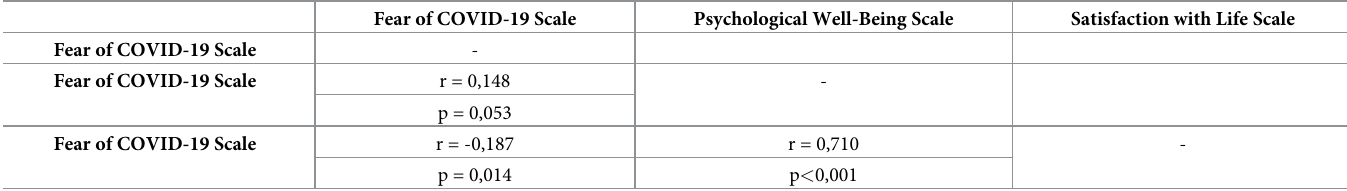
Table 4. The relationship between the fear of COVID-19, psychological well-being and satisfaction with life scales.